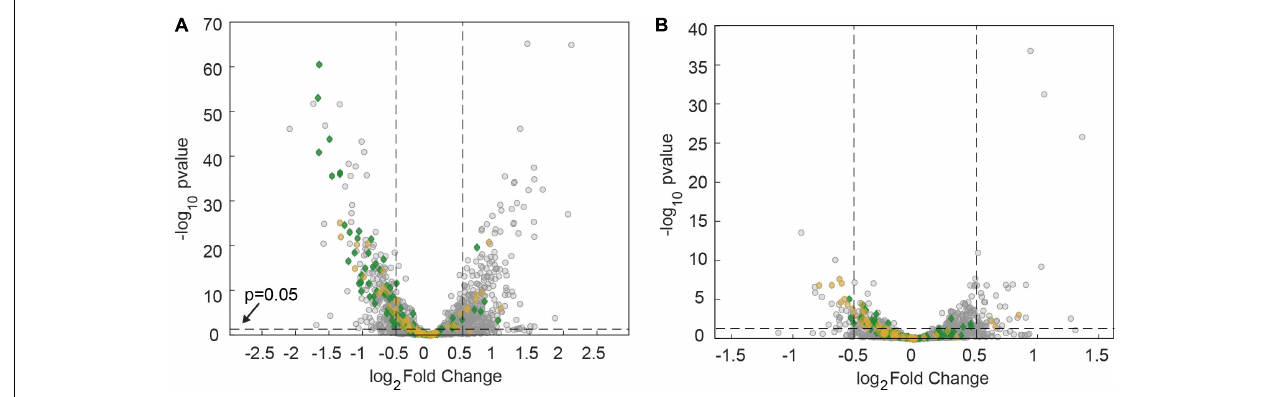
FIGURE 8 | Downregulation of metabolic genes after 60 min of antibiotic treatment at twofold MIC. Volcano plots showing adj. p -values as a function of the log 2 fold changes of RNA levels relative to the DMSO-untreated control determined by RNA sequencing. Gray: all genes. Green: genes involved in carbohydrate metabolism. Orange: Genes involved in energy metabolism. (A) Treatment with azithromycin. (B) Treatment with